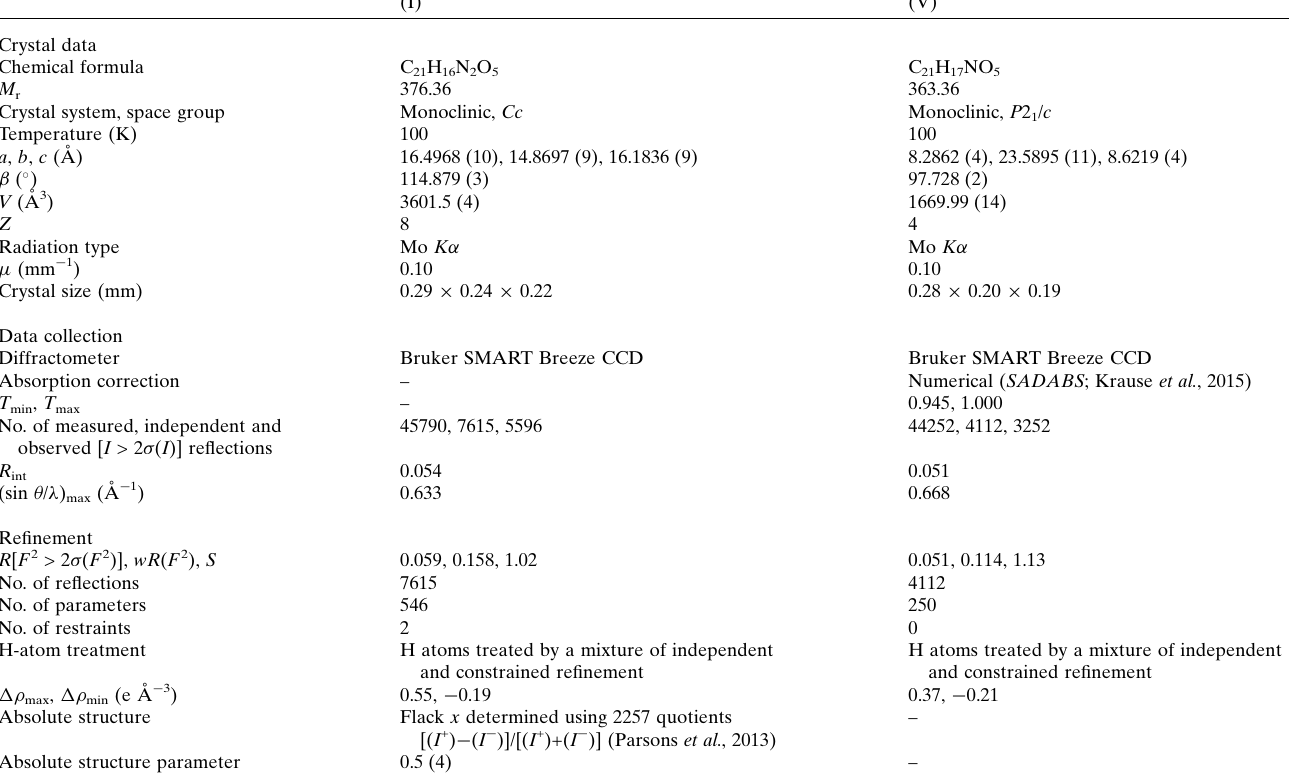
Table 3 Experimental details.